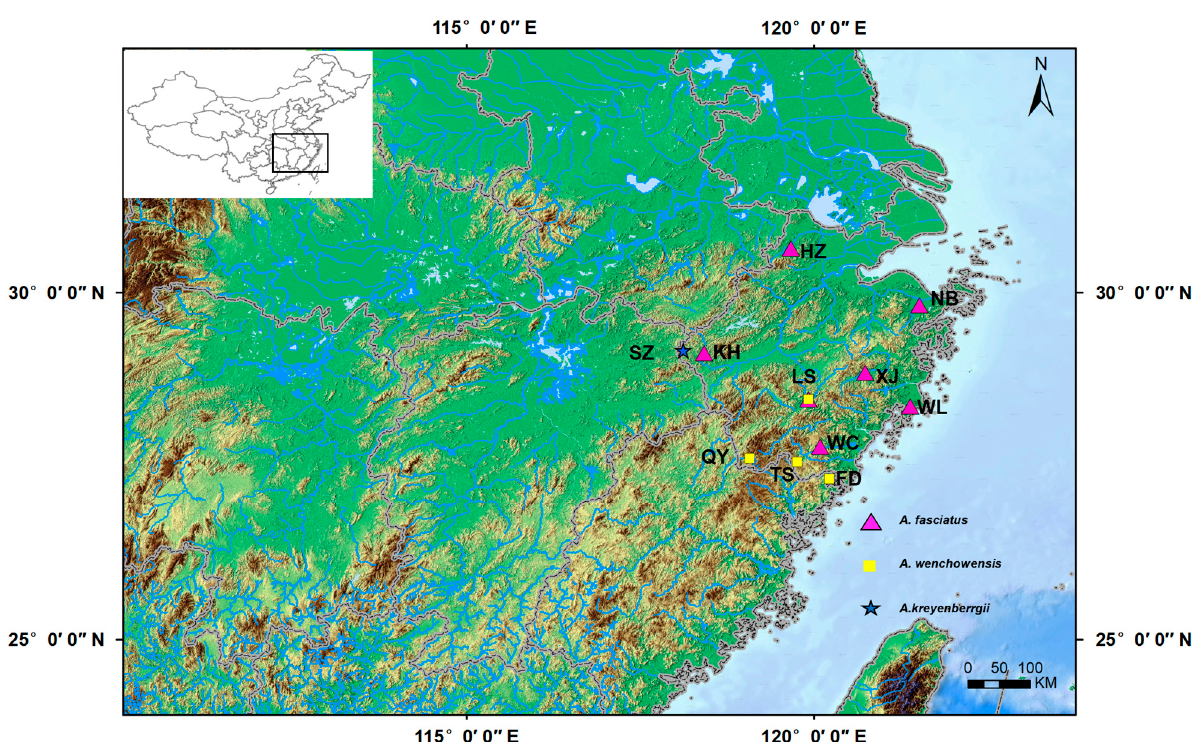
Figure 1. Map showing the 12 sampling localities of the 3 Acrossocheilus species examined in this study. Collection sites (triangles, squares, star) correspond to locations given in the text and Table 1. Total genomic DNA was extracted from the tissue of the fins using the DNeasy Blood and Tissue Kit (QIAGEN, Valencia, CA, USA). The complete mitochondrial cyt b gene (1140 bp) and control region (D-loop) region (949 bp) were amplified by polymerase chain reaction (PCR) using the primers CBW-F (5 (cid:48) -AGAAGCGACGGCGATTAG-3 (cid:48) ) plus CBW-R (5 (cid:48) -GAGCCAGTGGTGGGAGTTA-3 (cid:48) ) and LOOP-F (5 (cid:48) -AAGCATCGGTCTTGTAATCC-3 (cid:48) ) plus LOOP-R (5 (cid:48) -CCATCTTGGCATCTTCAGTG-3 (cid:48) ), respectively. PCRs were performed in 25 µ L total volume containing genomic DNA 3 µ L, Taq mix 12.5 µ L, 1 µ L of each primer and ddH 2 O 7.5 µ L. PCR was performed in an Eppendorf Mastercycler under the following conditions: 94 ◦ C for 4 min for initial denaturation, followed by 35 cycles of 94 ◦ C for 30 s, 55 ◦ C (cyt b); and 53 ◦ C (D-loop) for 40 s, and extension at 72 ◦ C for 1 min, and a final extension at 72 ◦ C for 10 min. All PCR products were purified, and the cycle sequencing reactions were run on an ABI PRISM 3730XL sequencer (Applied Biosystems, Foster City, CA, USA) using the BigDye Terminator kit (Applied Biosystems). The chromatograms were analyzed using CHROMA software, and sequence alignment was performed manually in BioEdit version 7.2.2.5 [12]. Sequences were submitted to GenBank under the accession numbers OP556253–OP556315 for cyt b and OP556361–OP556476 for the